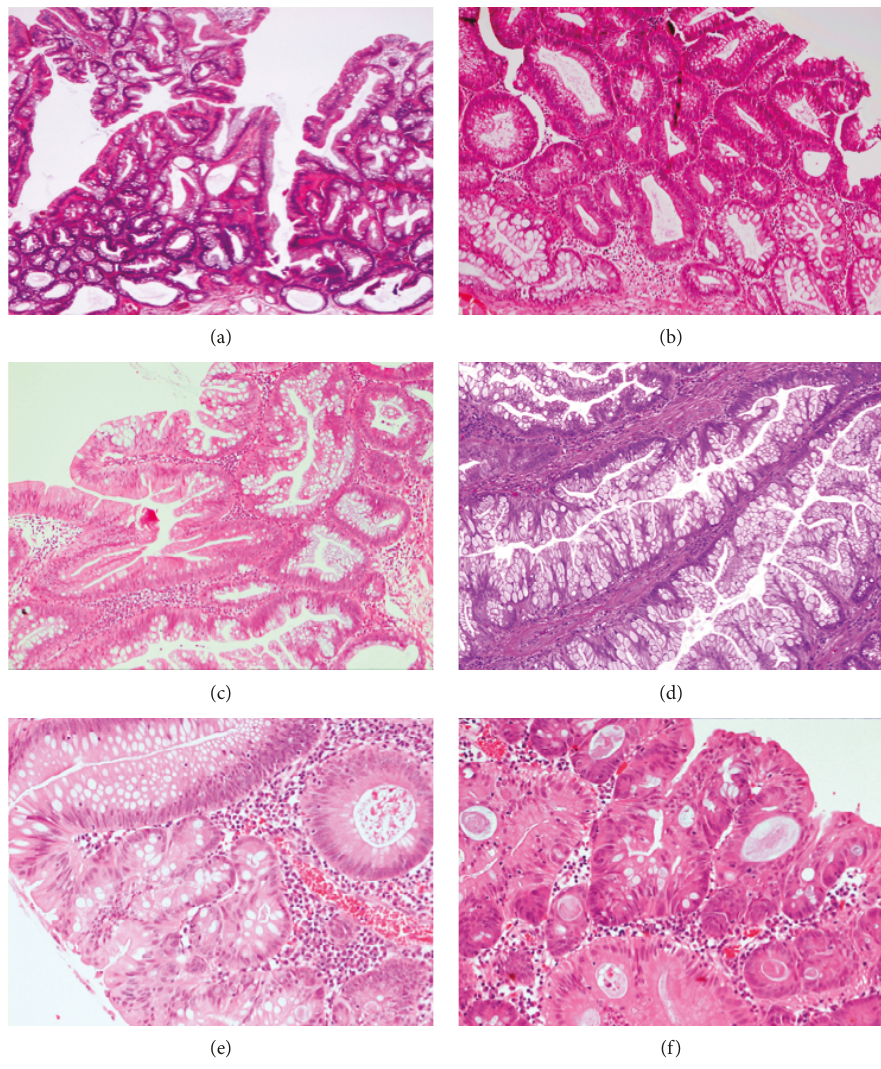
Figure 2: Sessile serrated lesion/polyp (SSL/P) without dysplasia (a). SSL/P with low-grade conventional adenomatous dysplasia (b). SSL/P with low-grade serrated dysplasia (c). Traditional serrated adenoma (TSA) without dysplasia (d). TSA with low-grade conventional adenomatous dysplasia (e). TSA with serrated dysplasia